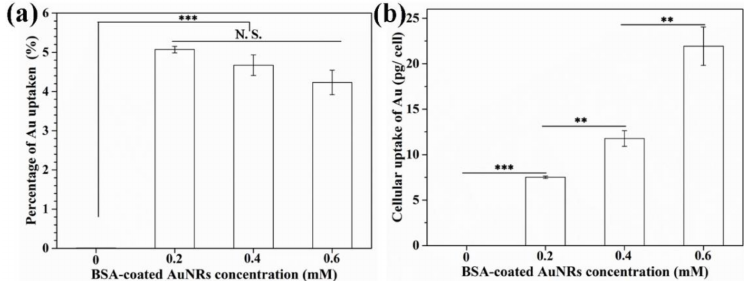
Figure 5. Percentage of Au uptaken by 4T1-Luc cells ( a ) and cellular uptake amount of Au per cell ( b ) after being cultured in medium containing BSA-coated AuNRs at different Au concentration of 0.0, 0.2, 0.4 and 0.6 mM for 6 h. Data are presented as mean ± standard deviation, n = 3. No significant difference: N.S.; Significant difference: ** p < 0.01; *** p <